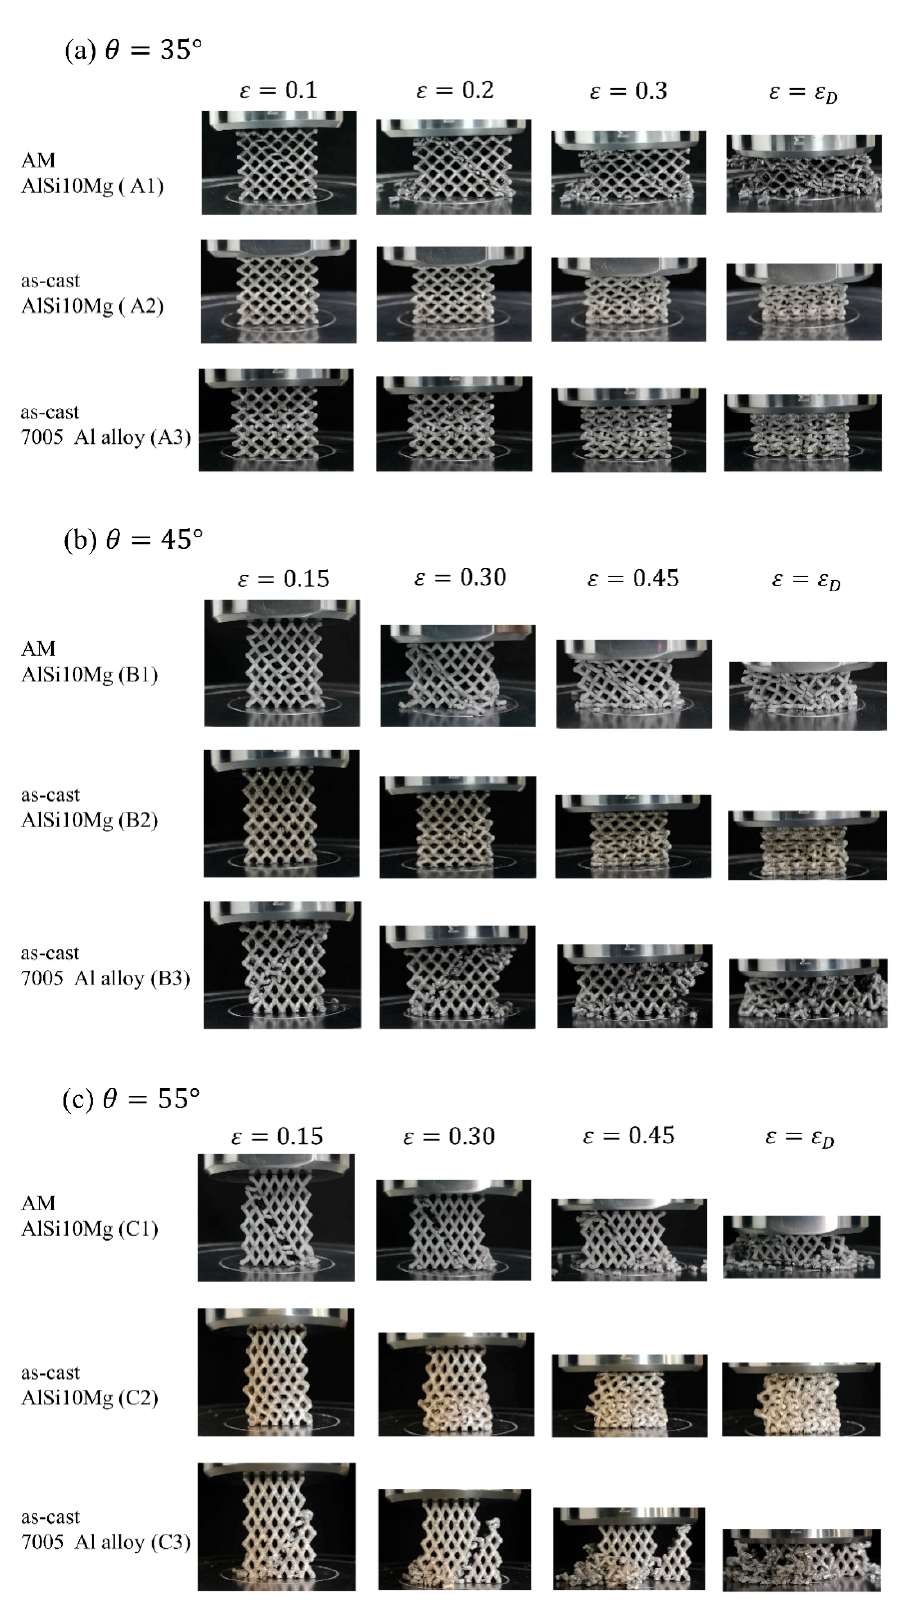
Figure 5. Deformation process of EP lattice structures in Group A, B and C; ( a – c ) represent the compression when the included angle is 35°, 45° and 55°, respectively